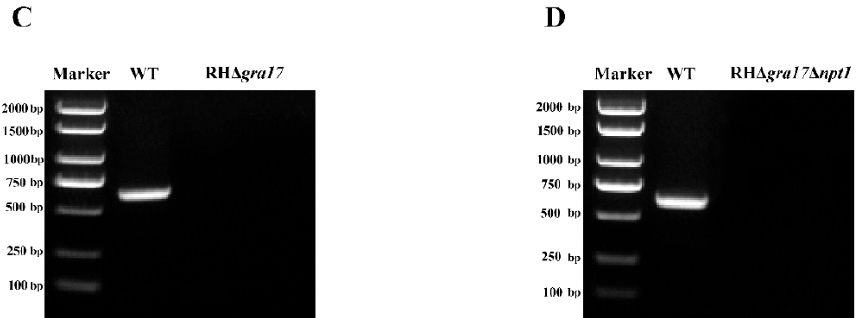
Figure 1. Generation of double gra17 and npt1 knock-out strains of T. gondii Type 1 RH strain using CRISPR/Cas9. ( A ) A schematic illustration of CRISPR/Cas9 system used in disrupting the gra17 gene by insertion of pyrimethamine-resistant DHFR (DHFR*) cassette. ( B ) Schematic showing deletion of npt1 gene by insertion of a phleomycin-resistant Ble into npt1 gene. The KO-forward and KO-reverse primers were used to amplify the small fragment. ( C ) Diagnostic PCR showing that a small fragment was lost due to insertion of the DHFR* cassette with short extension time in the gra17 mutant strain compared to the wild-type strain. ( D ) Diagnostic PCR showing the successful knockout of the npt1 gene in the RH Δ gra17 strain.